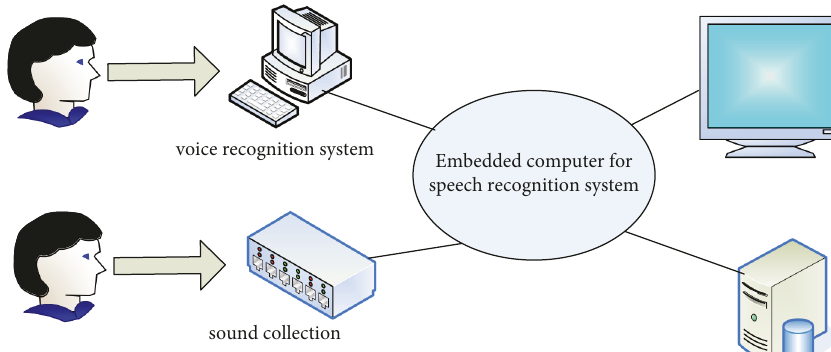
Figure 2: Block diagram of the speech recognition